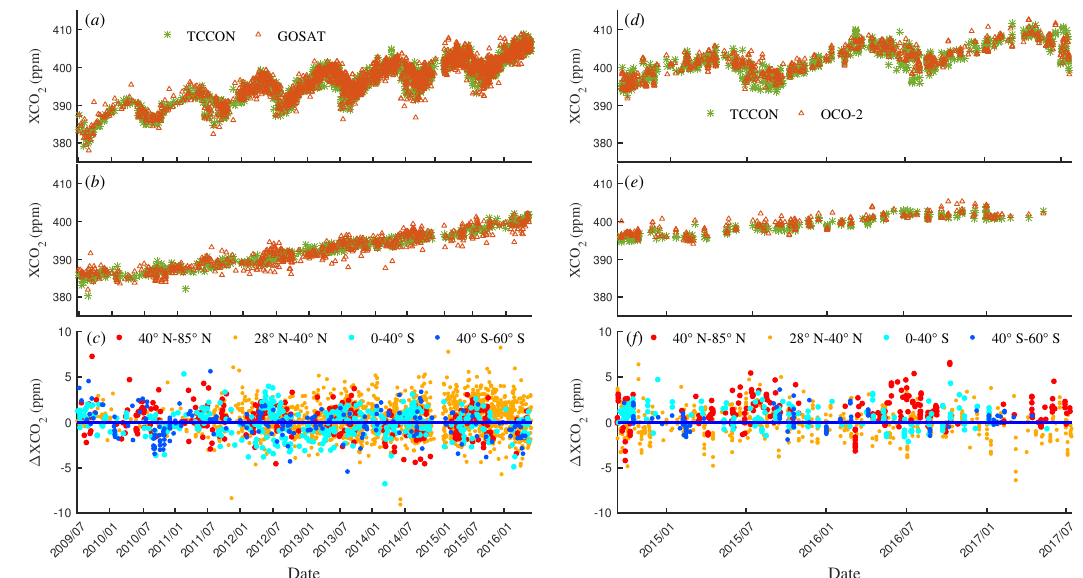
Figure 8. Time series of the satellite XCO 2 , the coinciding TCCON data and their differences. The right panel shows the time series of the coincidences between the GOSAT XCO 2 and TCCON soundings in ( a ) the Northern Hemisphere and ( b ) Southern Hemisphere and ( c ) the difference between the GOSAT and TCCON XCO 2 ( ∆ XCO 2 = GOSAT − TCCON). The left panel shows the time series of the coincidences of the OCO-2 XCO 2 and TCCON soundings in the ( d ) Northern Hemisphere and ( e ) Southern Hemisphere and ( f ) ∆ XCO 2 (OCO-2 −